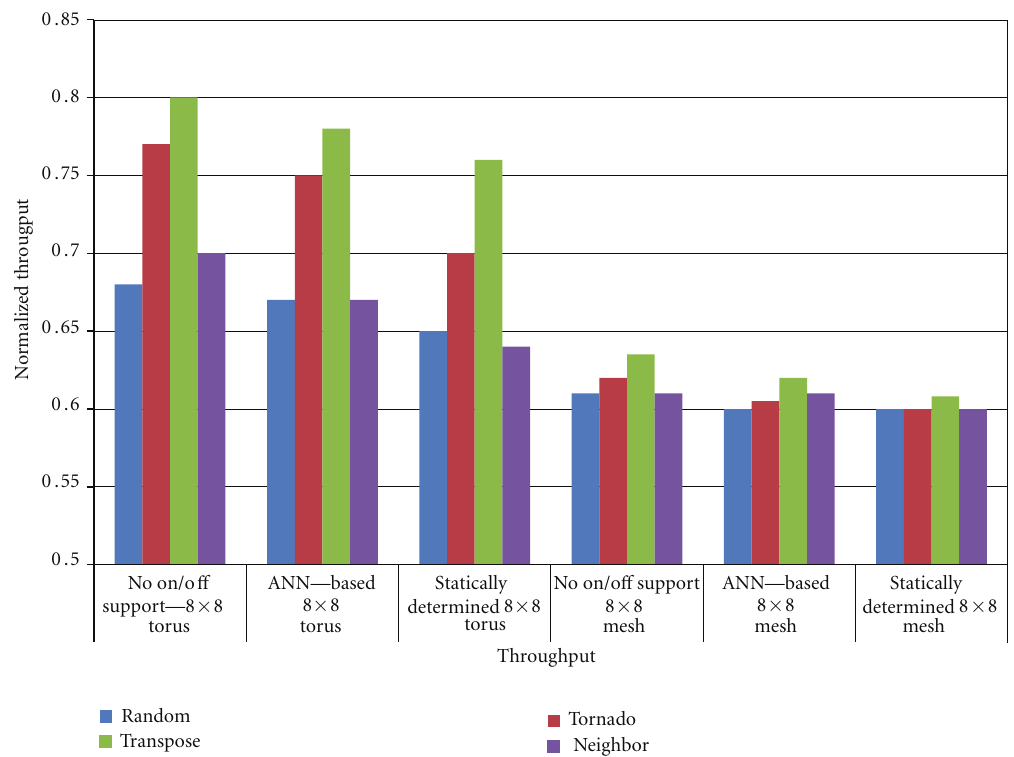
Figure 10: Average network throughput comparisons for 8 × 8 mesh and torus networks.